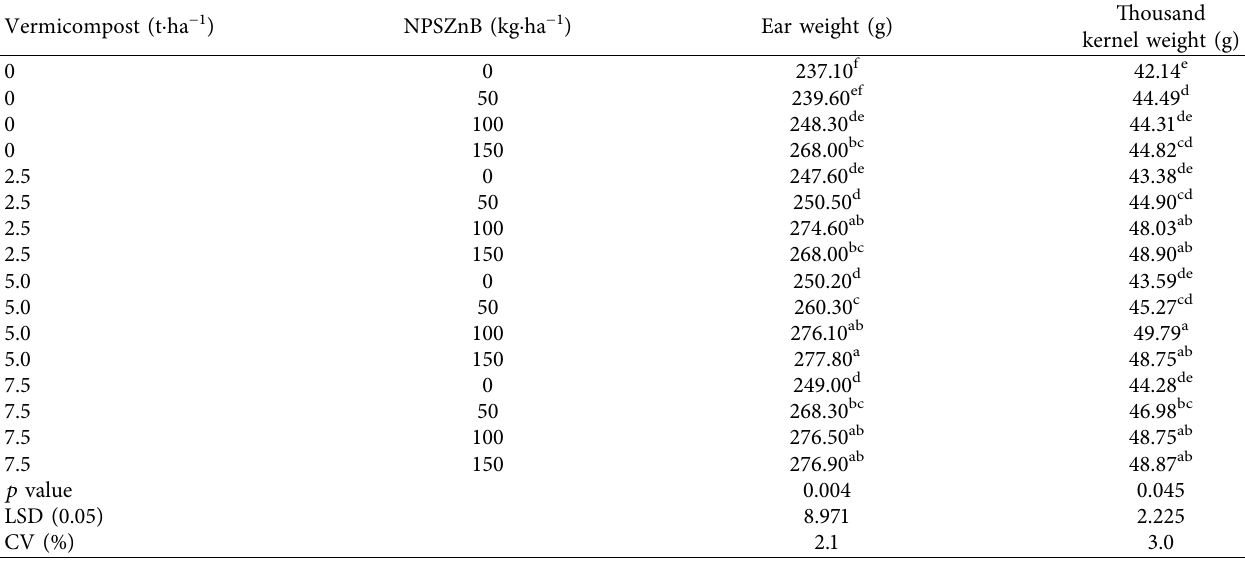
Table 5: Interaction efect of vermicompost levels and inorganic NPSZnB fertilizer rates on-ear weight (g) and thousand kernel weight (g) of maize in Guto Gida, Western Ethiopia. Vermicompost (t · ha − 1